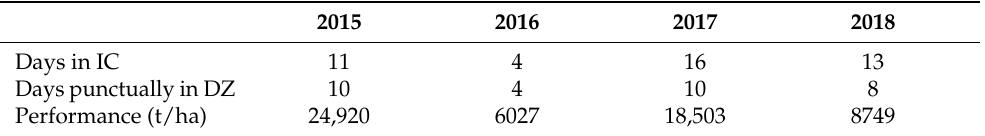
Table 7. Ratio of days in ideal conditions (IC), conditions in dangerous zone (ZP) together with the performance of the cherry crop in Extremadura (Spain) in the analyzed